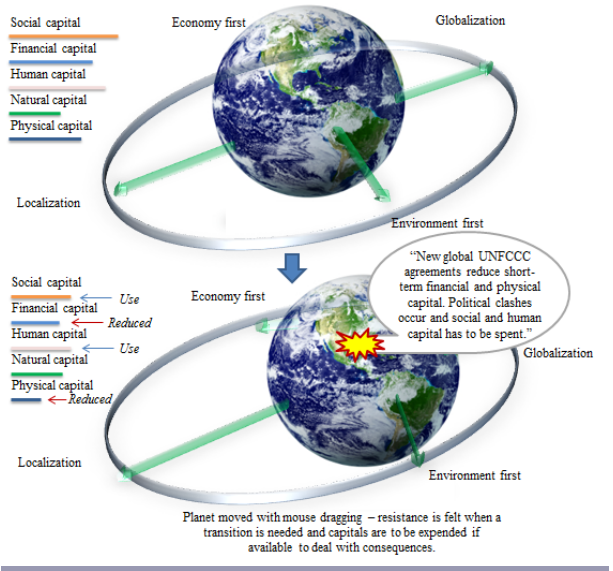
Fig. 5 . Simplified example of basic Spaceship Earth